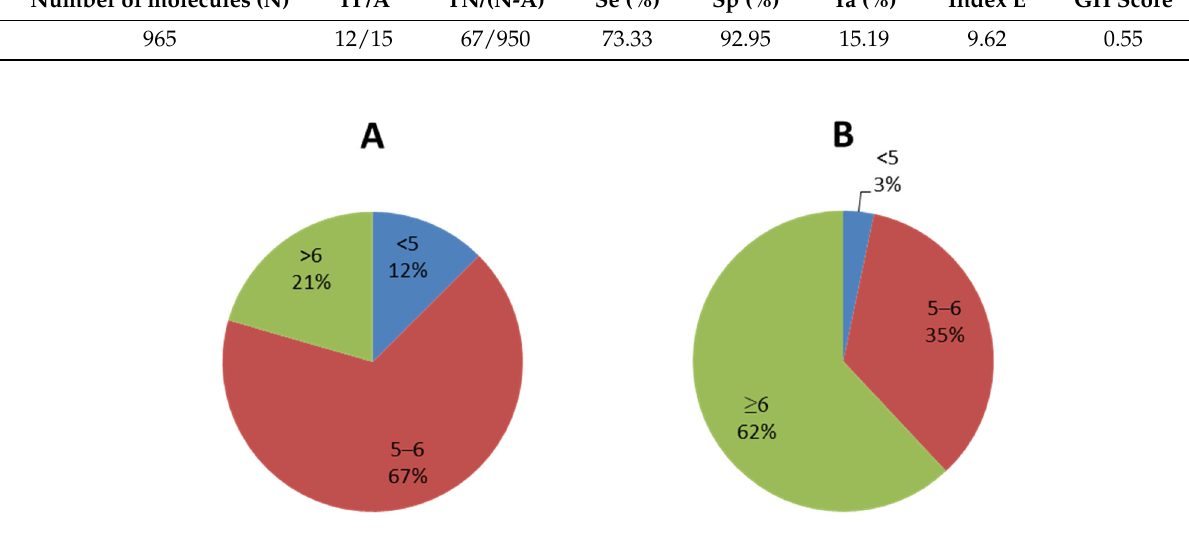
Figure 4. Factors of five-point pharmacophore model. F3, F4 ( the blue ): hydrogen bonding acceptors (Acc2); F2, F5 ( the green ): hydrophobic groups (Hyd); F1 ( the orange ): an aromatic ring or π conjugated ring (Aro|PiR). 2.2. Molecular Docking Model 2.2.1. Homology Model Homology model was created from 655 amino acids of ABCG2 in www.uniprot.org (accessed on 17 Sep. 2019) by SWISS-MODEL server [14] (Figure 5). This model was built from the model 6hbu.1.A, which was an electron microscopy model [15]. The model struc- ture consisted of two protein chains, each of which forms half of the ABCG2 transport pump. Each half-channel included 6 integral membrane fragment. A short fragment of ATP-binding was located inside the cell, while the area outside the cell obtained disulfide bonds. In general, this structure was similar with others that had been built by electron microscope photography [16]. The model’s evaluation is shown in Figure 6. The GMQE